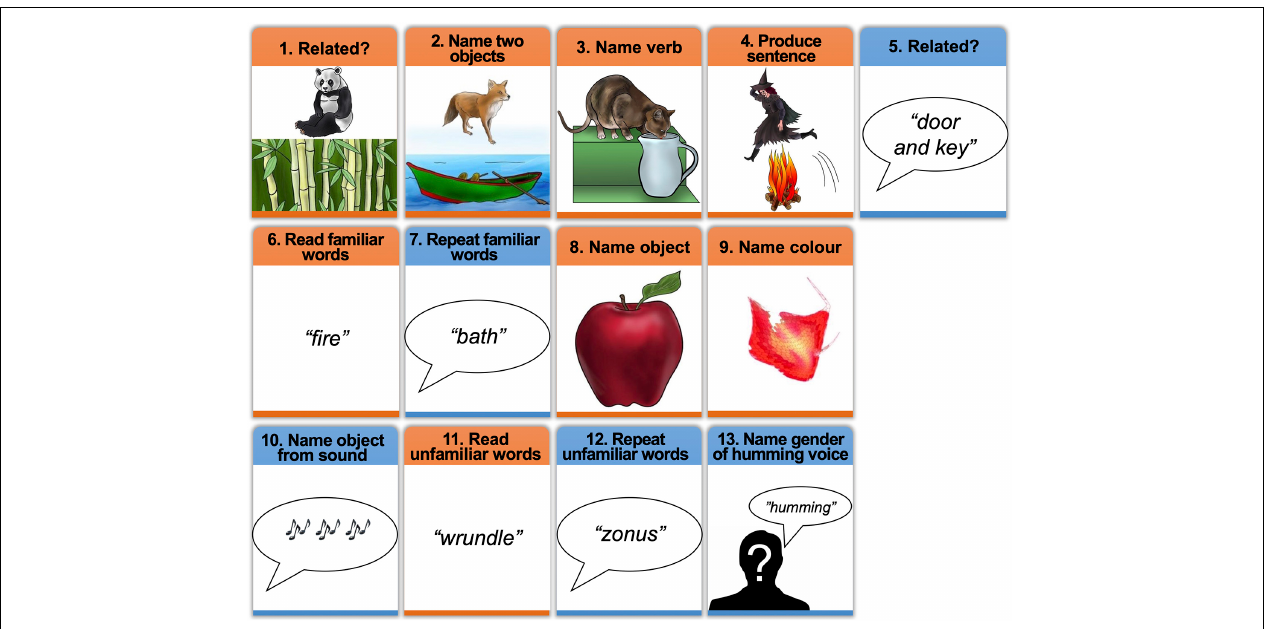
FIGURE 2 | Schematic of the experimental tasks with examples of stimuli. The order of tasks (1–13) was the same for all participants in Group 2. Tasks 6–13 were also presented to Group 1, in counterbalanced order. Orange boxes = tasks in the visual modality, Blue boxes = tasks in the auditory modality. In task 10 (naming object from sound), participants heard a sound (e.g., a guitar playing) and were asked to name the object that produced the sound (e.g.,